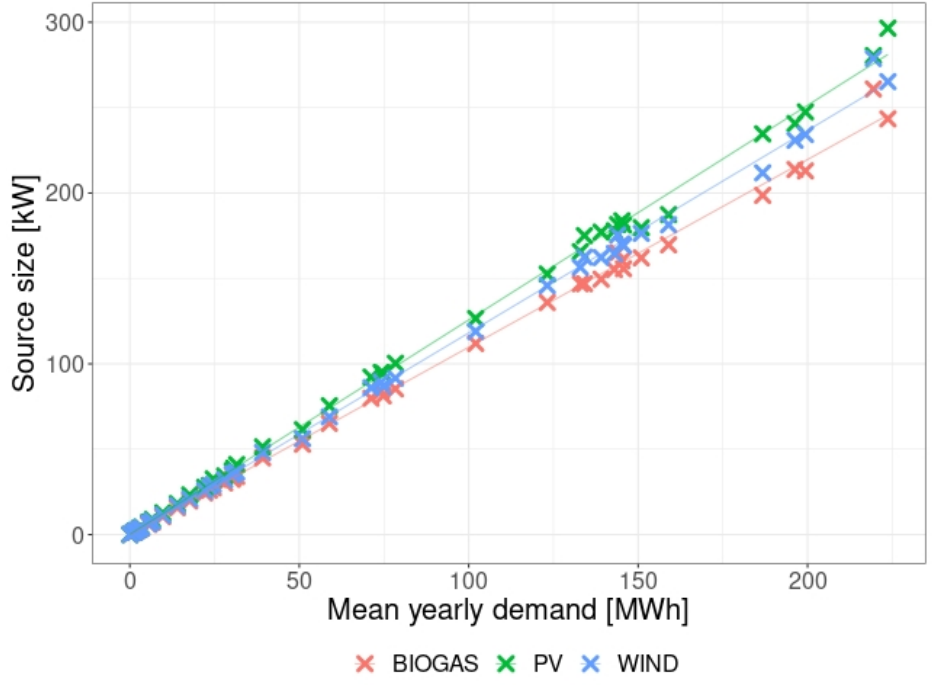
Figure 2. Source capacity by generation technology and average energy demand. The Polish electricity market is a daily and hourly market, which means that energy prices and energy balancing are based on an hour. The prosumer’s annual demand for electricity is therefore not a sufficient criterion in terms of optimization and the objective function determined. The assumptions made at the preliminary stage in accordance with the applicable regulations indicate that the selection of generating source capacity must